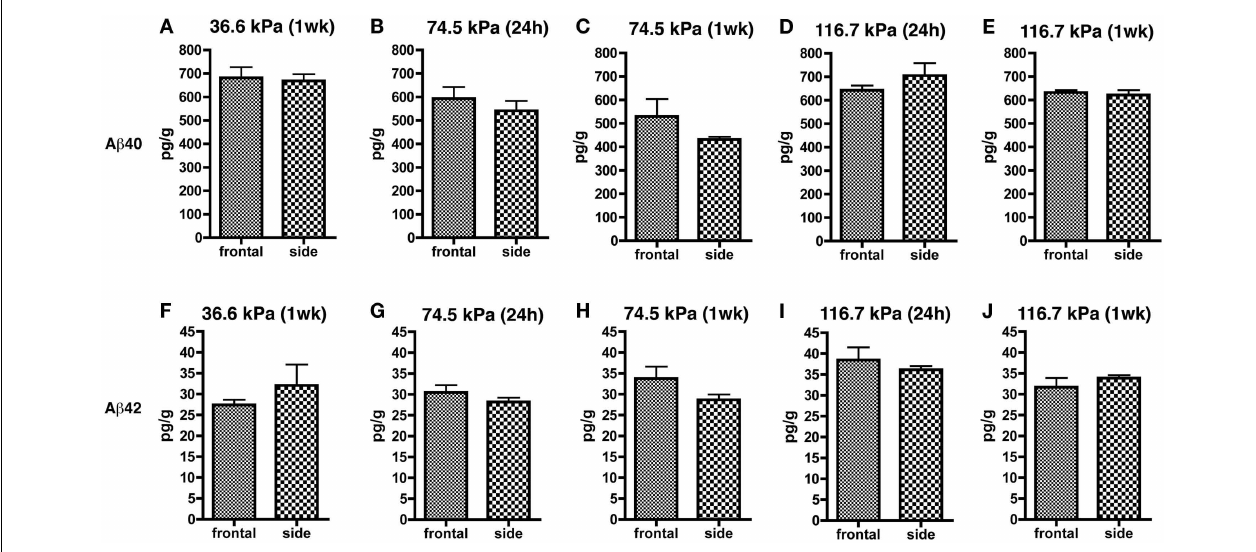
the pair wise comparisons (unpaired t -tests) demonstrating that orientation to the blast had no effect on levels of A β 40 or 42. Further statistical tests are discussed in the text. Sample sizes were: (A,F) (6 frontal and 4 side), (B,G) (8 frontal and 10 side), (C,H) (3 frontal and 5 side), (D,I) (5 frontal and 4 side), and (E,J) (4 frontal and 5